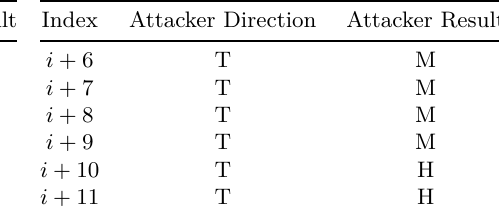
Table 2: The result of executing the attacker’s target branch with the TBDV “000,000,111,111”, in which “0” means “not taken” and “1” means “taken” (running the attacker process alone). M – misprediction, H – hit (correct prediction), N – not taken, T –